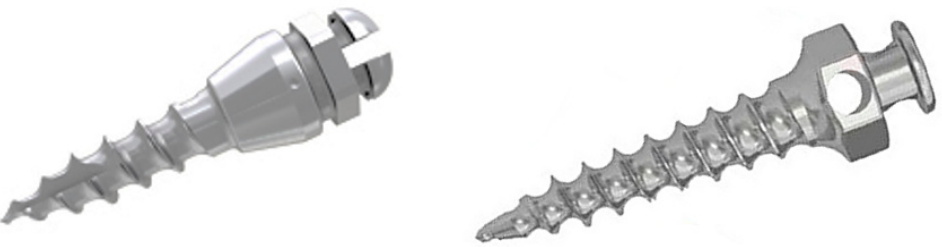
Figure 1. Mini-implants (right-to-left: Perfect Anchor and Tomas ® -pin, respectively).